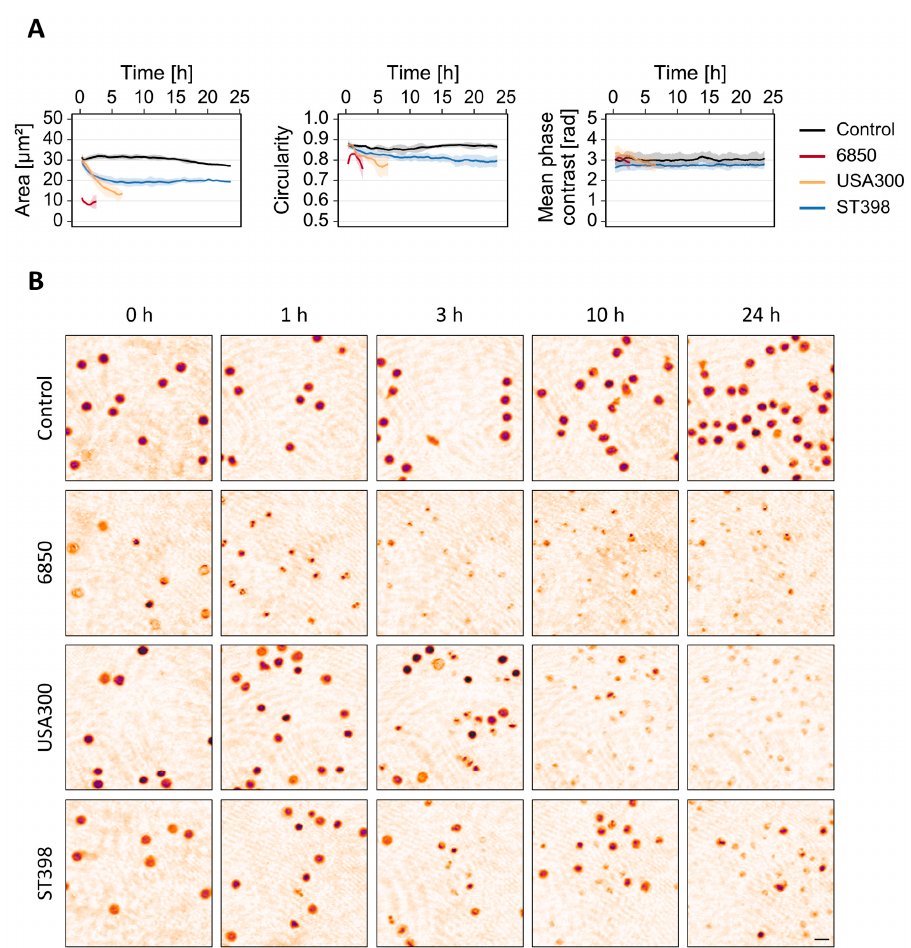
Figure 3. S. aureus MVs induce rapid changes in T-cell morphology that vary between different strains. Human primary T-cells were treated with MVs (2 × 10 9 particle/mL) derived from different S. aureus strains or left untreated as control. The phenotypical cell response was recorded over 24 h by timelapse DHM. ( A ) Average cell area, average circularity and mean phase contrast per cell were analyzed using quantitative phase contrast images. Results represent mean (solid lines) ± SD (shading) of at least three independent biological replicates. The curves were smoothed using moving averages with a window size of 15 measuring points. ( B ) Representative pseudo-colored phase contrast images at indicated measurement time points. The scale bar corresponds to 10 µm.